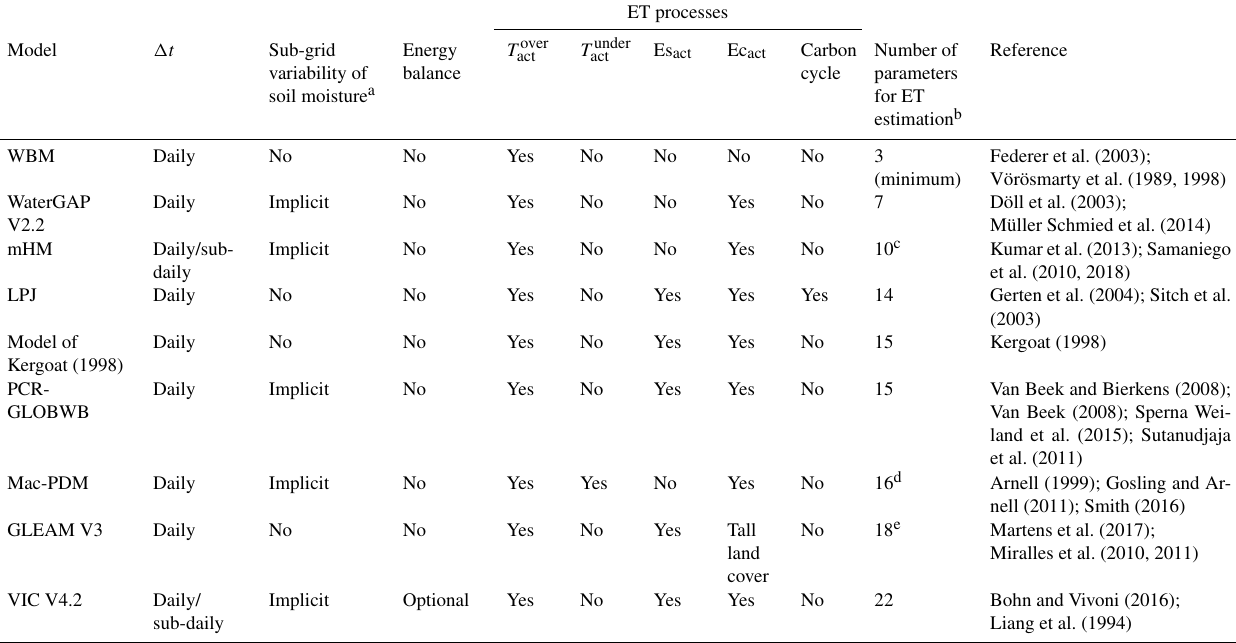
Table A1. Characteristics of selected large-scale models: simulation time step ( (cid:49)t) , representation of sub-grid variability of soil moisture, solving of the energy balance, ET processes represented (overstorey transpiration T over act , understory transpiration T under act , soil evaporation Es act , evaporation from canopy interception Ec act and carbon cycle i.e. vegetation dynamic model), and number of parameters for ET estimation. The models were selected based on the following criteria: (1) explicit representation of land cover properties, (2) calculation of ET and soil water balance at a daily or sub-daily time step, and (3) applications in previous studies over a wide range of climate and land cover types. Tables A2 and A3 present the parameterisations used in these models, while a detailed list of all parameters involved in the representation of ET in these models can be found in Sect. S2 of our